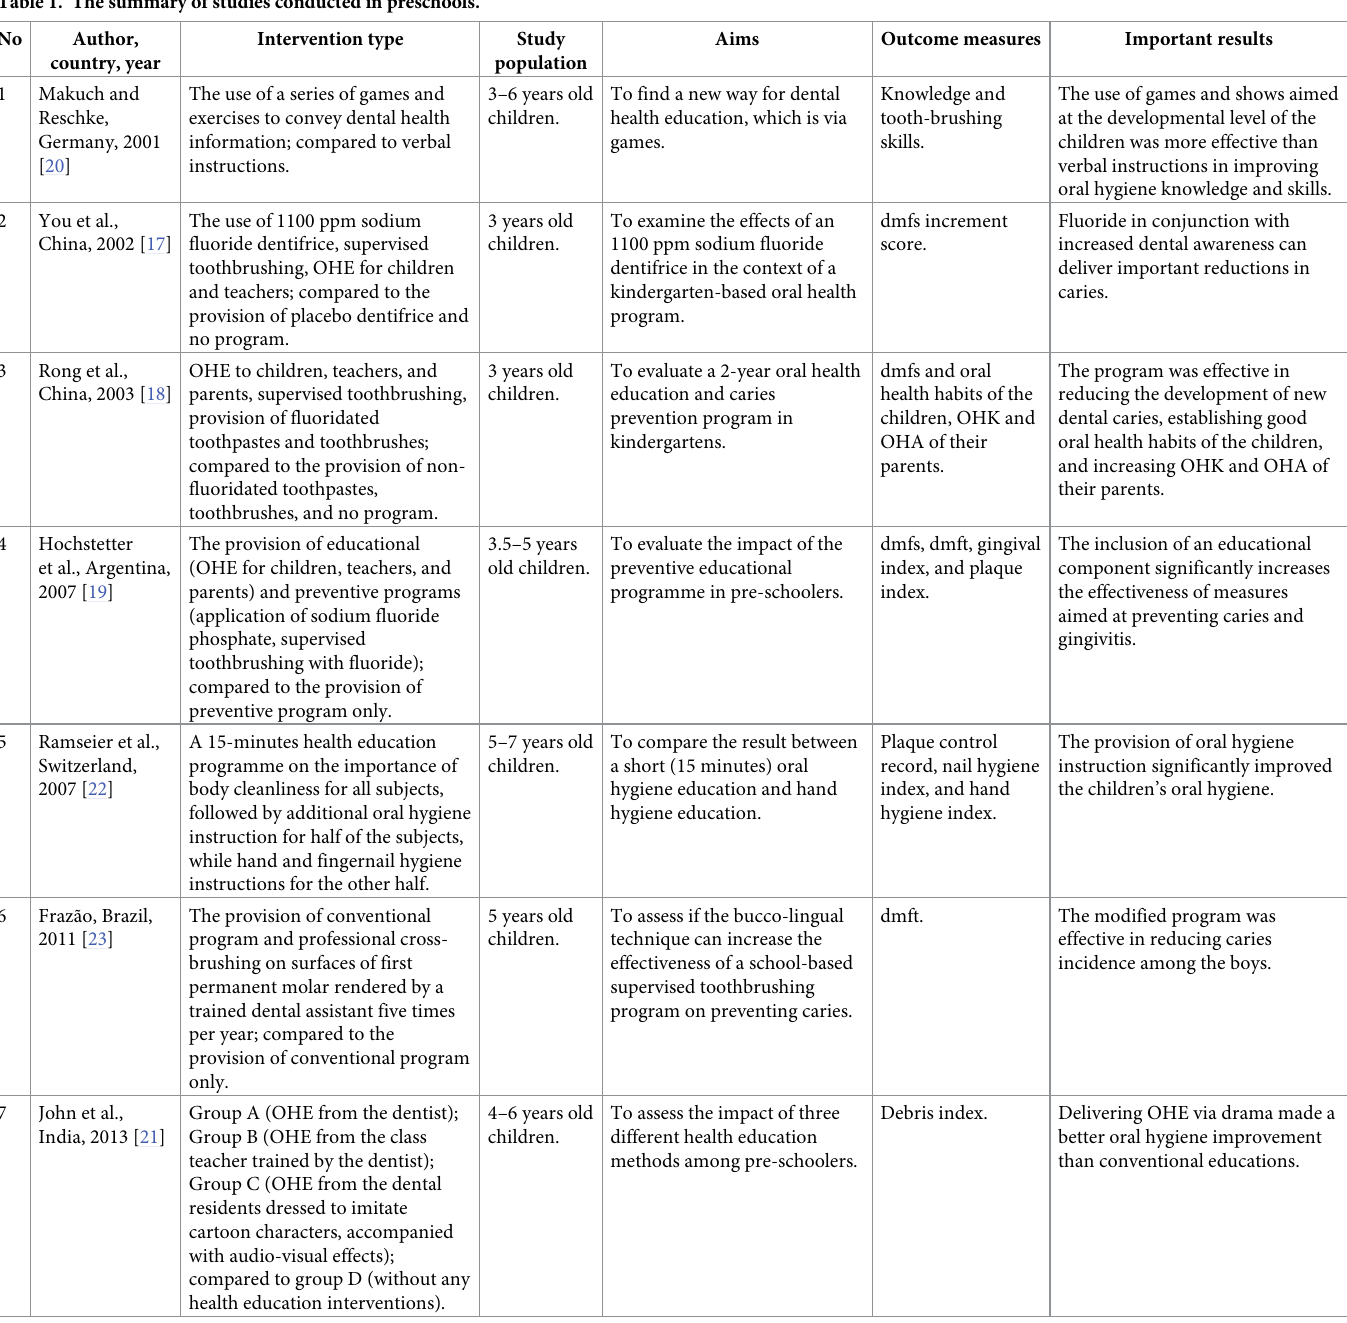
Table 1. The summary of studies conducted in